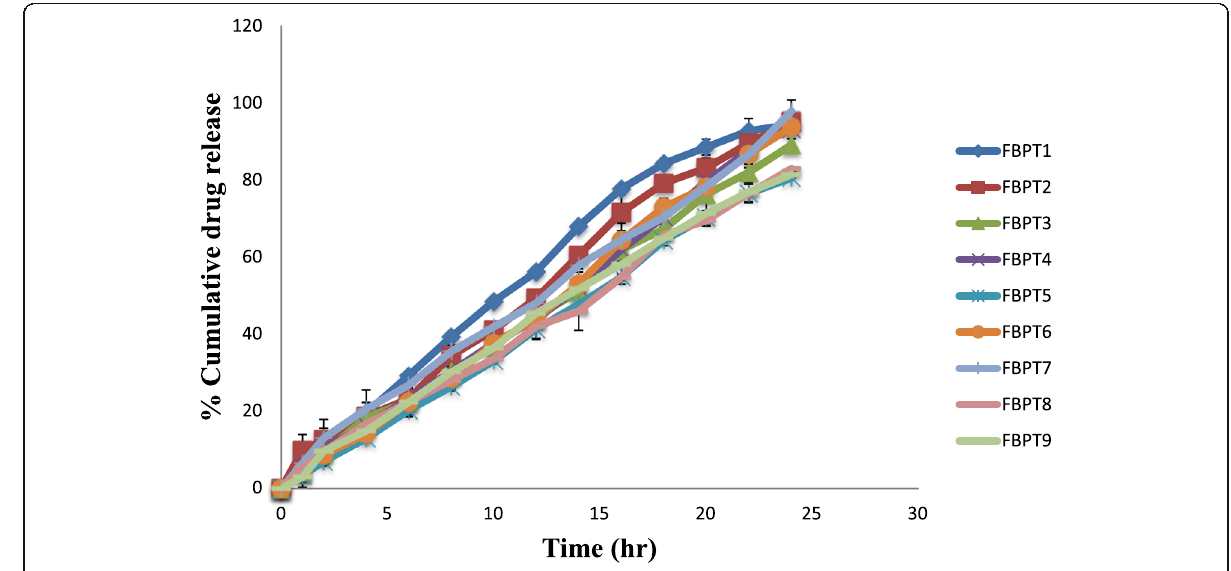
Fig. 6 In vitro drug release profile of transdermal films